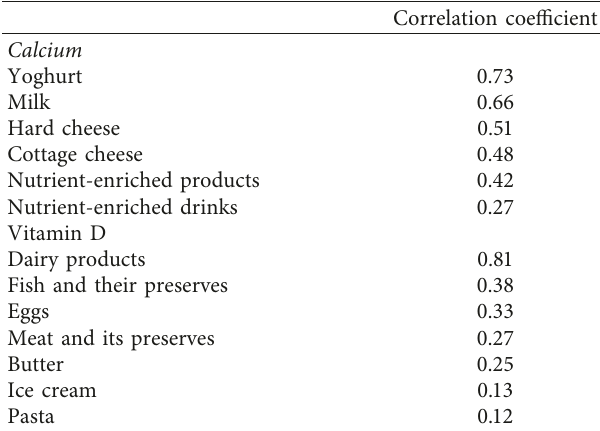
Table 4: Correlation between calcium and vitamin D intake and consumption of particular products ( p ≤ 0 .